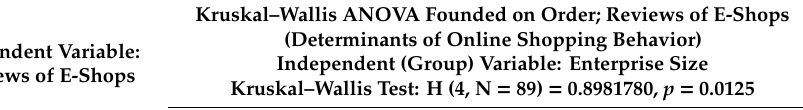
Table 8. Kruskal–Wallis ANOVA founded on order; Example: Reviews of e-shops according to enterprise size Source: own processing (in the Statistica